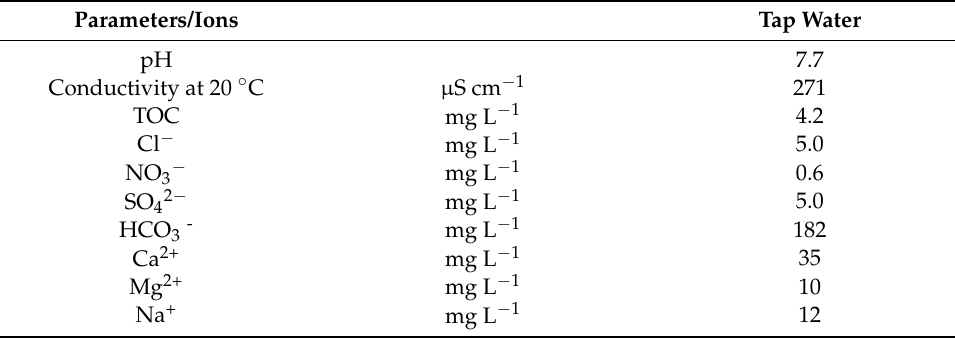
Table A1. Physico-chemical characterization of tap water